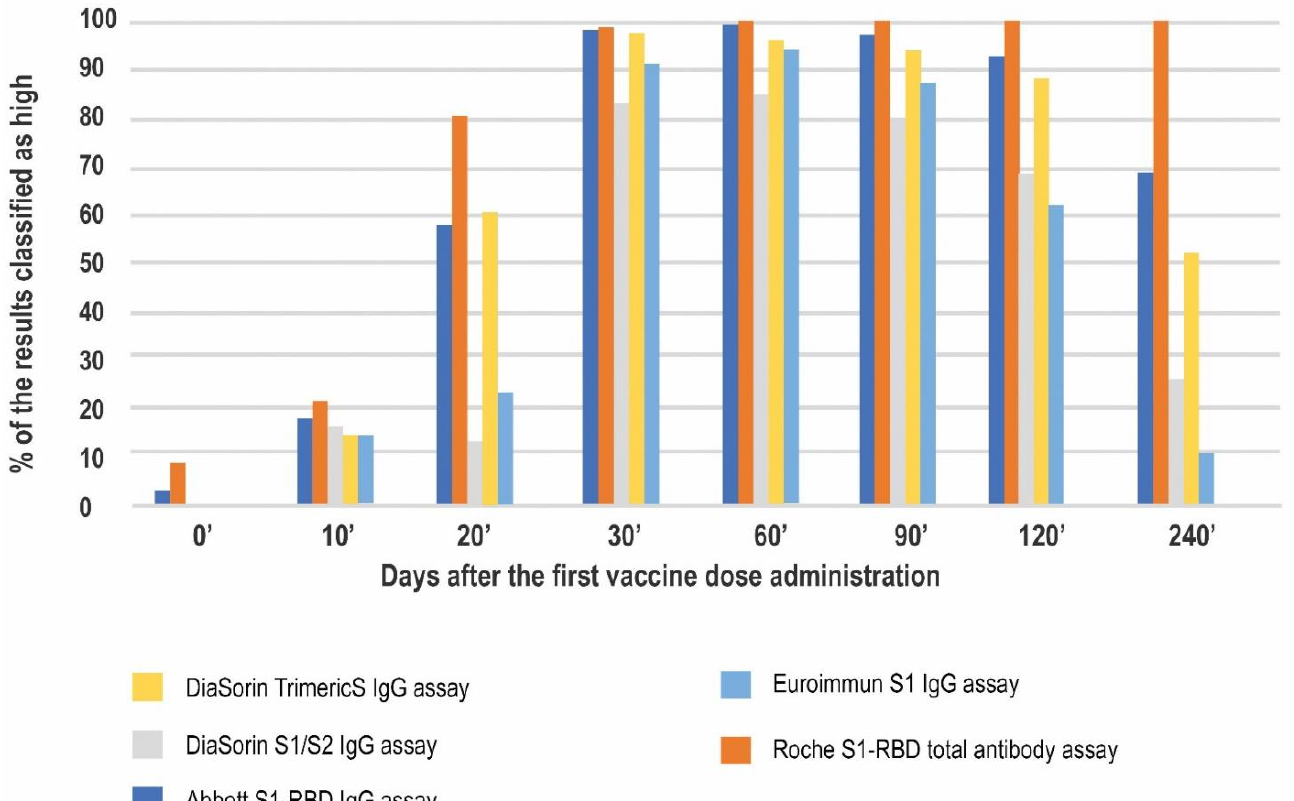
Figure 5. The percentage of results that were classified as high based on the arbitrary chosen cut- off.